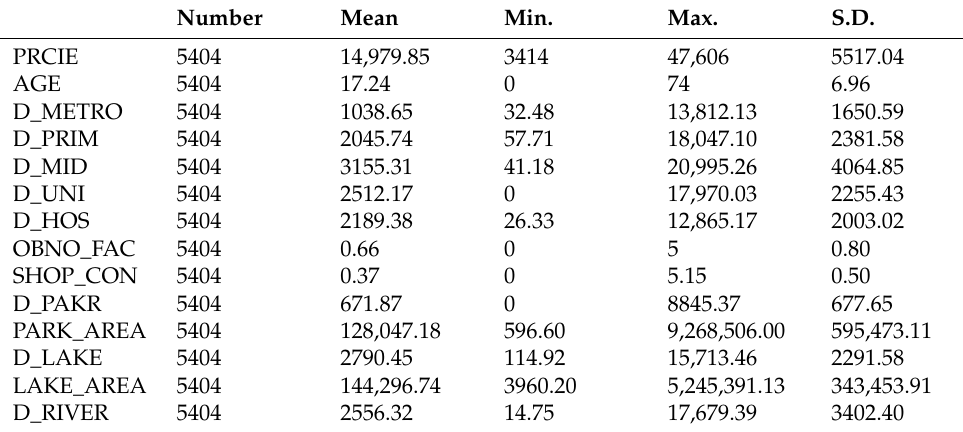
Table A2. Descriptive statistics of data in Chengdu.